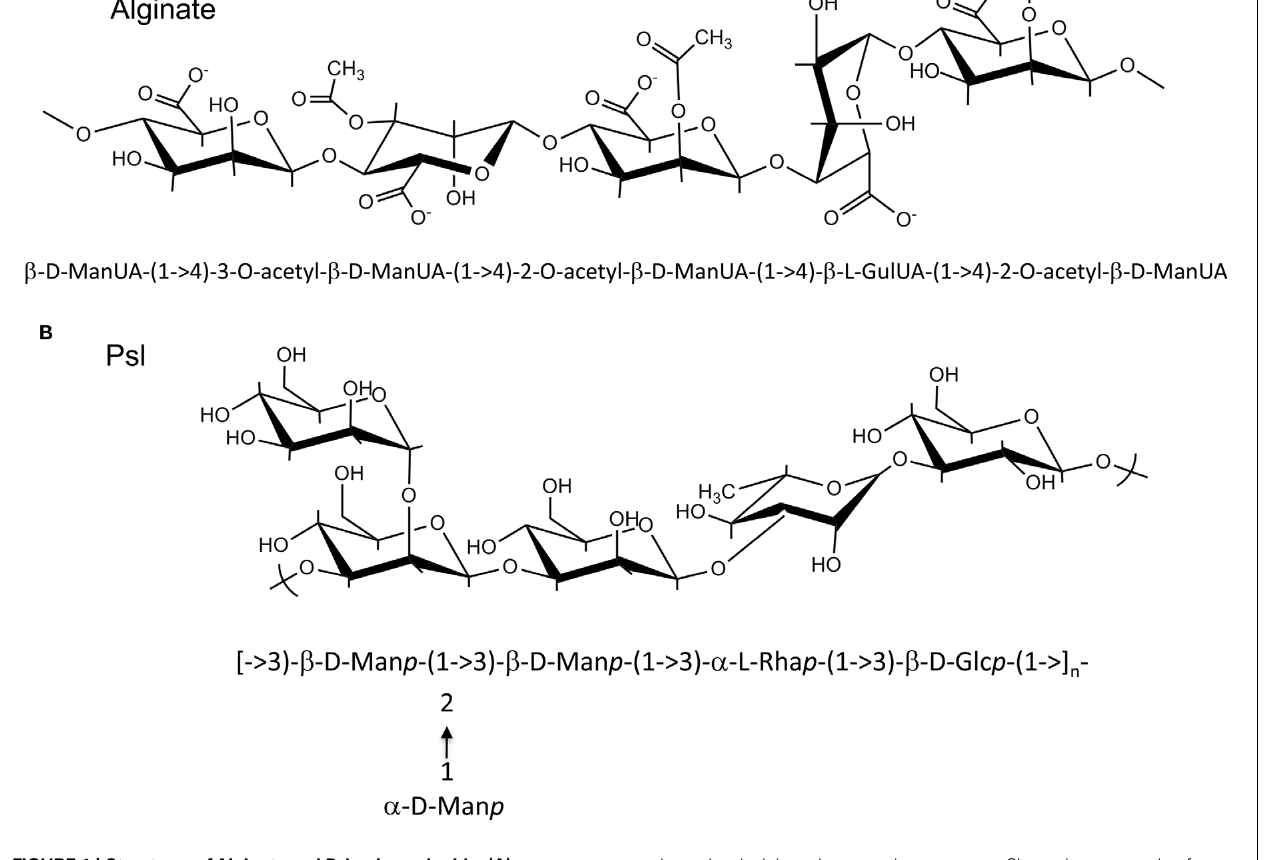
polymer level, alginate has a random structure. Shown is an example of a possible alginate subunits arrangement, where D-mannuronate subunits are epimerized to L-guluronate or decorated with O-acetyl groups. (B) Psl polysaccharide is composed of a repeating pentamer consisting of D-mannose, L-rhamnose, and D-glucose